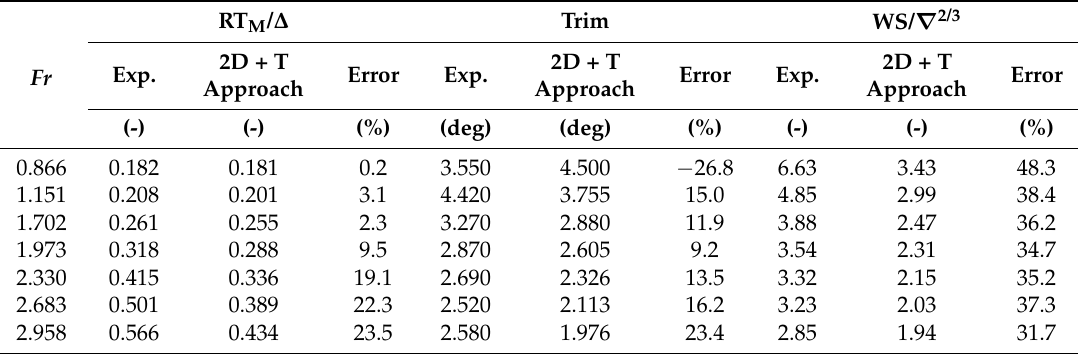
Table 2. The comparison between the experimental and analytical results.